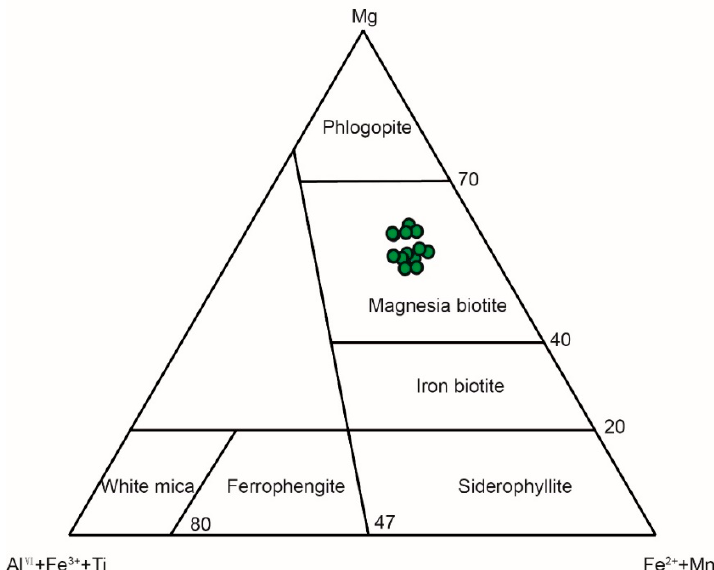
Figure 7. Biotite classification map [53].